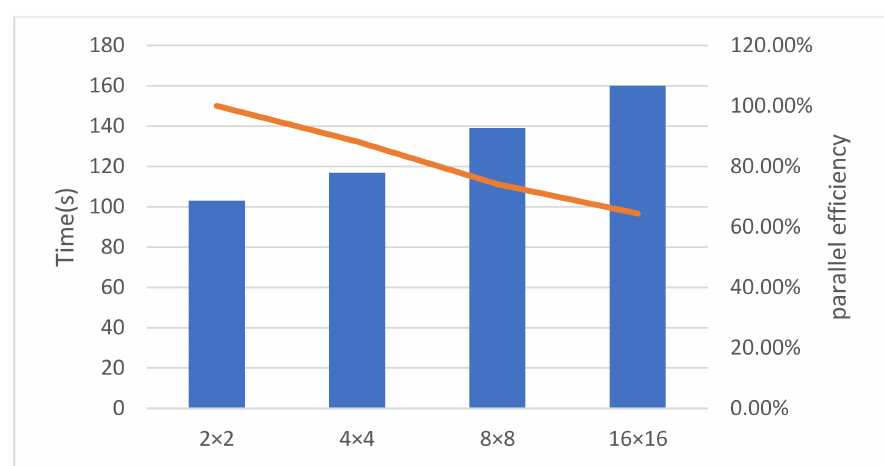
Figure 11. Optimized heterogeneous parallel weak scaling test.